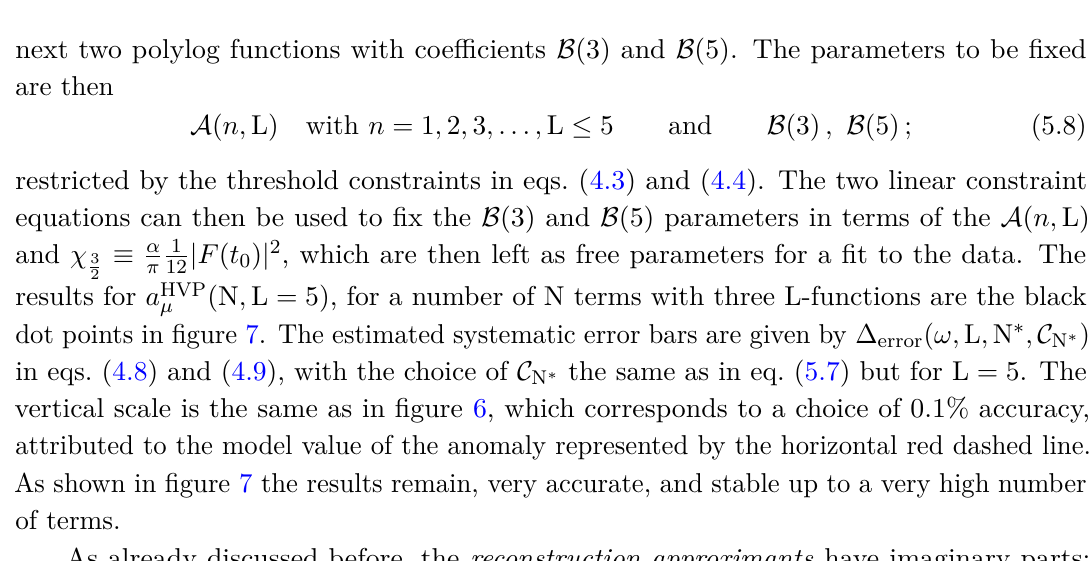
(N , L = 5) results with estimated systematic error bars. The horizontal red dashed Figure 7 . a HVP µ line is the a HVP value of the µ